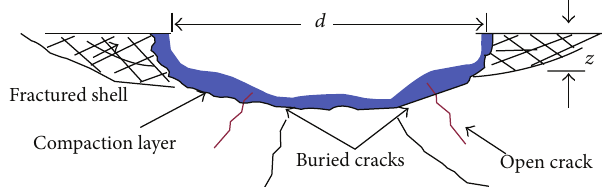
Figure 5: Schematics of damage crater morphology [44].